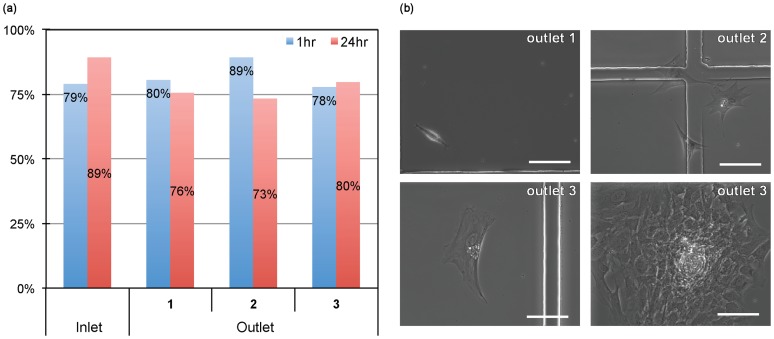
Processed cells remain highly viable.(a) Colorimetric viability test showed that cells flowed through the device remain highly viable similar to control cells, which have not been processed. (b) Collective bright field images of 10 day cultured cells. Various cell types with different morphologies were observed. Scale bar is 100 µm.